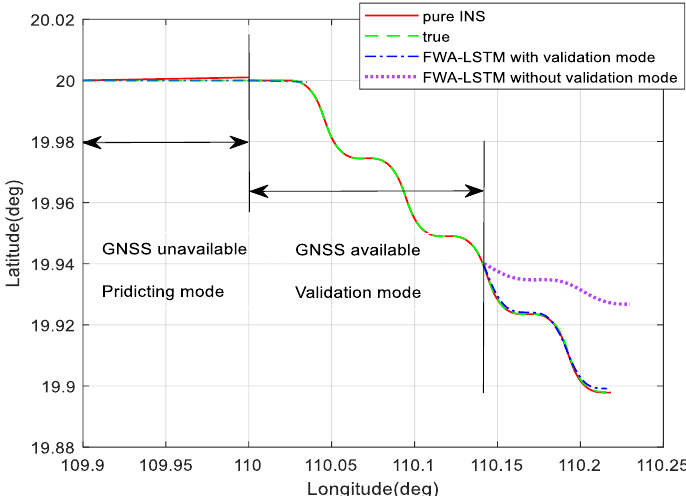
Figure 12. Comparison of prediction results with or without validation mode.